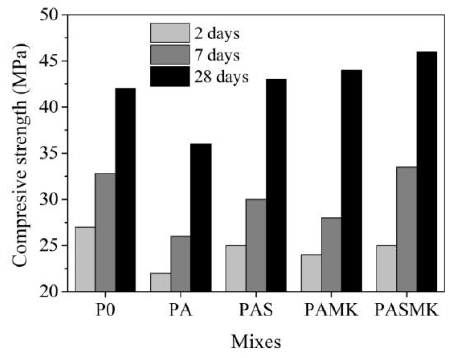
Figure 11. The compressive strength of P0 – PASMK samples after 2, 7, and 28 days.